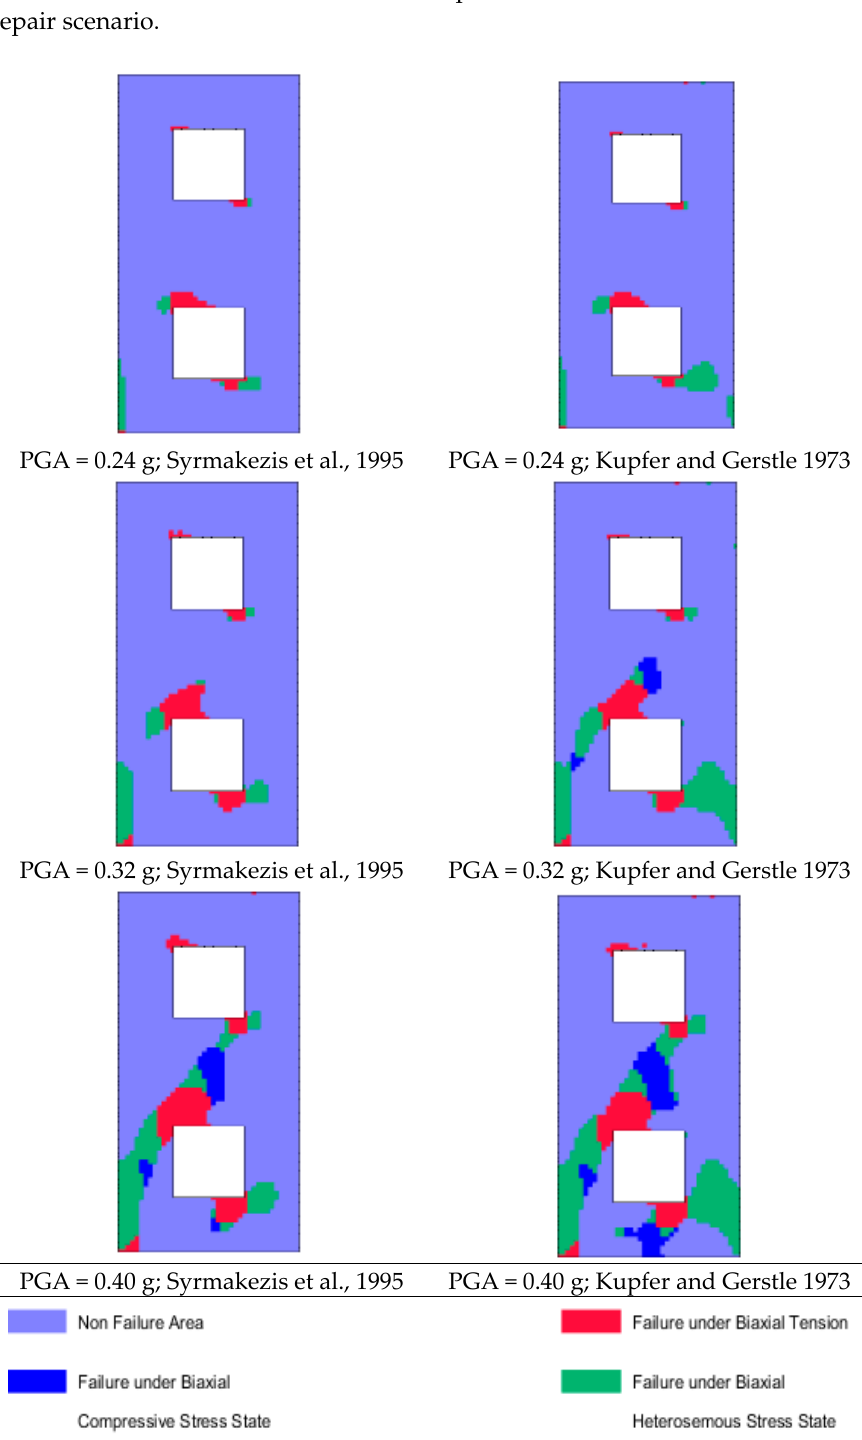
Figure 37. Failure of 2D masonry wall L50H100 (Figure 11a) with two openings, two different failure criteria and three different values of PGA.